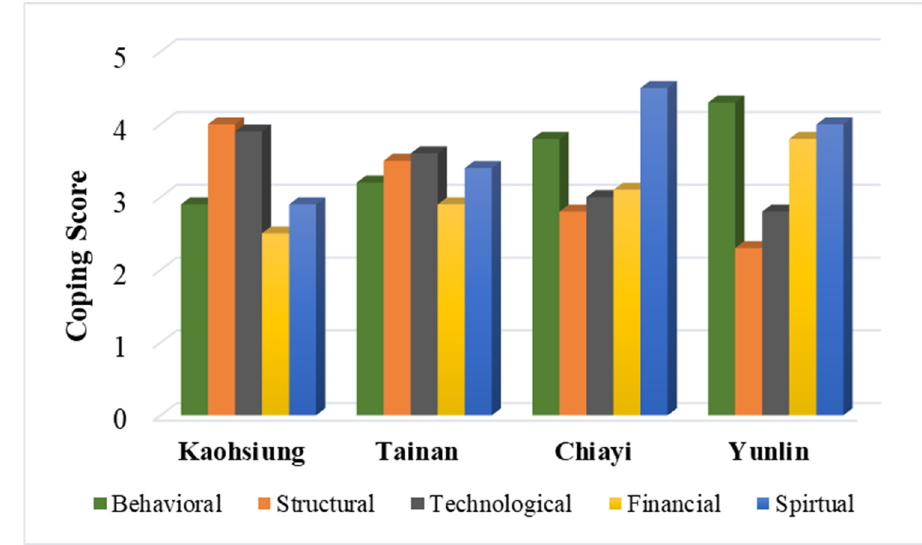
Figure 6. Coping scores achieved by coastal residents of the least resilient cities.